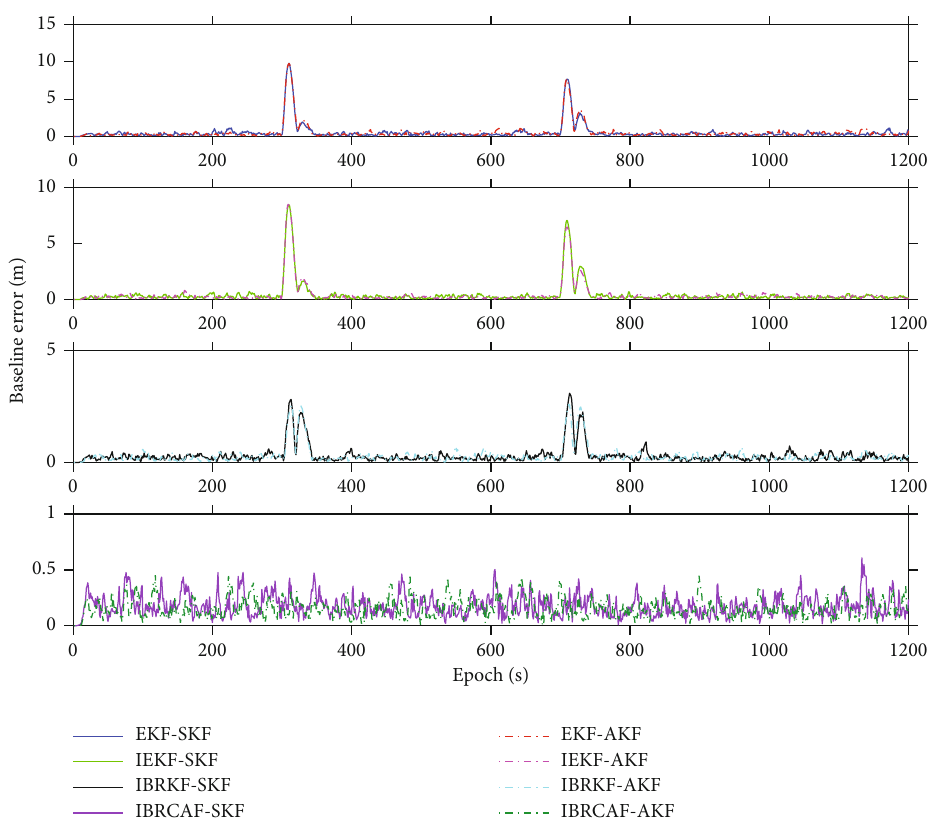
Figure 22: The baseline errors of various algorithms (Data